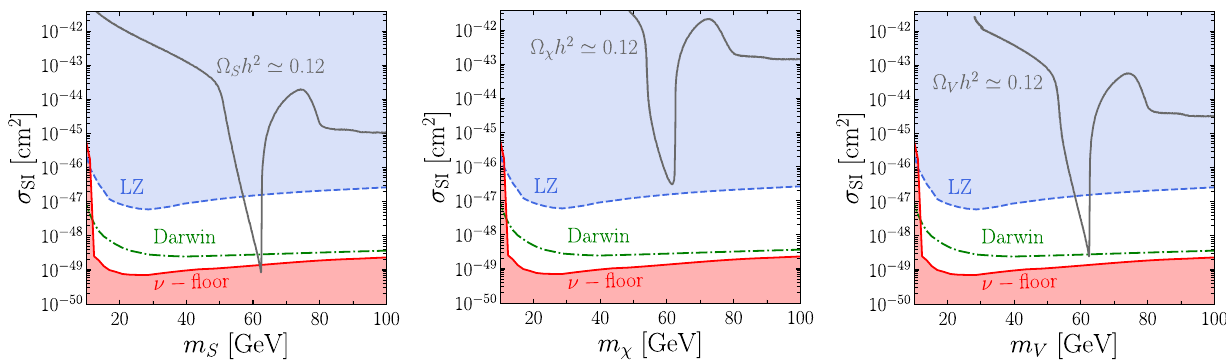
Fig. 5 σ SI asafunctionoftheDMmassfortheHiggs-portalparameter space in which the relic abundance as observed by Planck is reproduced (dark grey), for scalar DM (left), Dirac fermion DM (center) and vector Fig. 6 Higgs-portal parameter plane of dimensionless couplings and the DM mass for scalar DM S (first row), Dirac fermion DM χ (second row) and vector DM V (third row). The dark-grey lines indicates the parameter space reproducing the relic abundance as observed by Planck. Constraints from LZ, projection for Darwin and the neutrino floor are represented in dashed blue, dotted-dashed green and solid red respectively. In the plots on the right, the LZ constraint is rescaled according to the predicted DM abundance via Eq. (3.4), and the light-grey areas represent regions where the DM relic abundance exceeds the Planck value. The solid black and dotted-dashed orange lines represent respectively our constraints derived using HiggsSignal and constraints from direct searches for the invisible decay of h